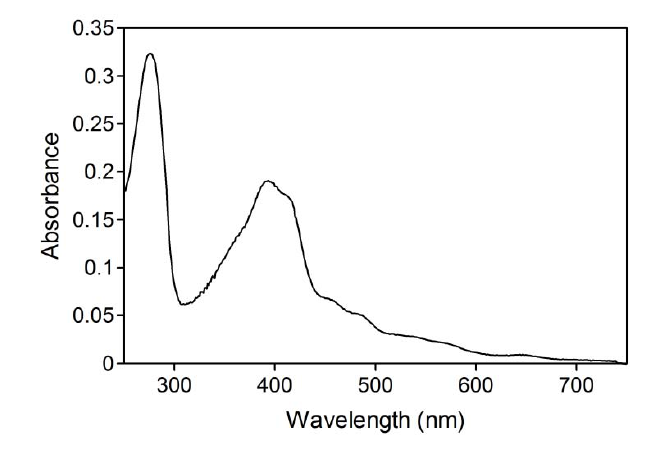
Figure 4. UV-Vis spectrum of 2 μ M branched P450cam with 5 mM d -camphor in the reversed micellar system at a W of 0